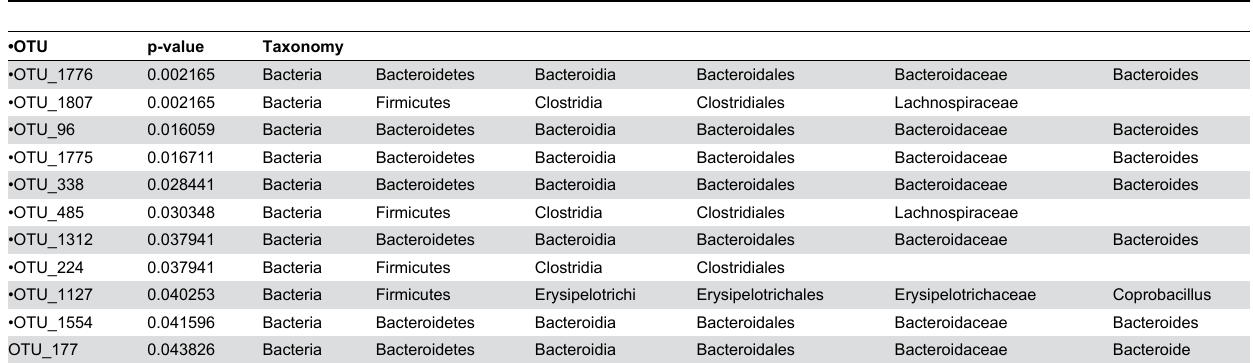
Table 1. Differential OTUs leading to the separate clustering of the healthy and colon polyps samples the sub-genus level data